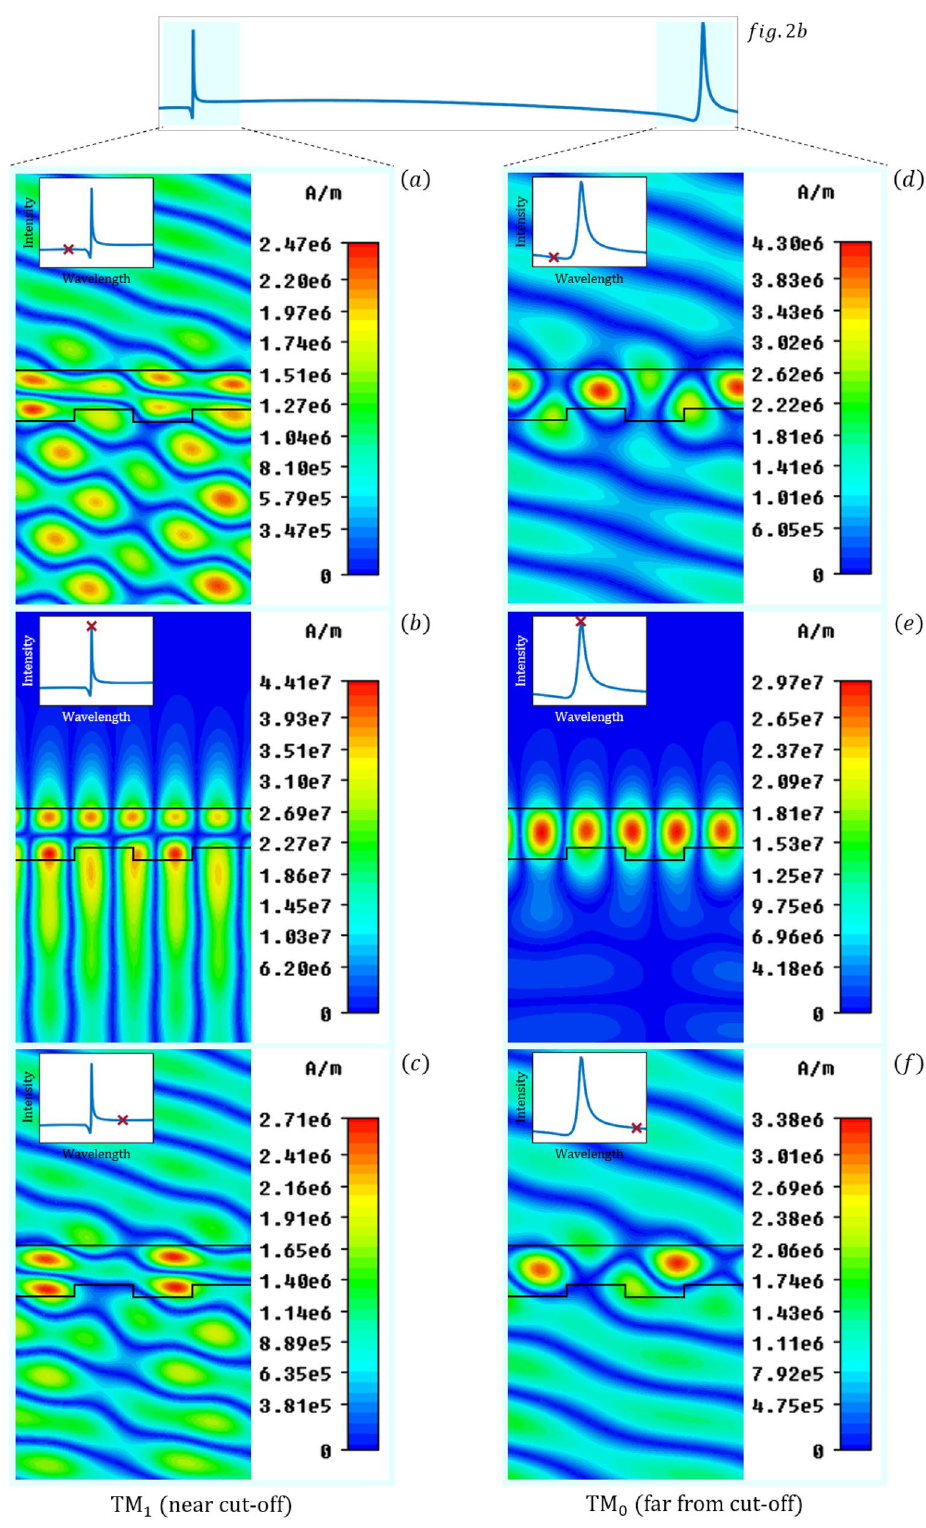
Figure 4. The magnetic field distributions before, at and after the resonant peak of the TM 0 and TM 1 resonances. The TM wave incident from the substrate side with an incidence angle of 26° produces field enhancement in the waveguide and an evanescent field at the sensor surface at the resonant wavelengths upon full reflection. It transmits through the grating structure at the off-resonance wavelengths. The stronger localization of the mode power inside the waveguide film for the TM 0 far-from cut-off mode is observed. The magnetic field distributions are calculated by CST Studio Suit 37